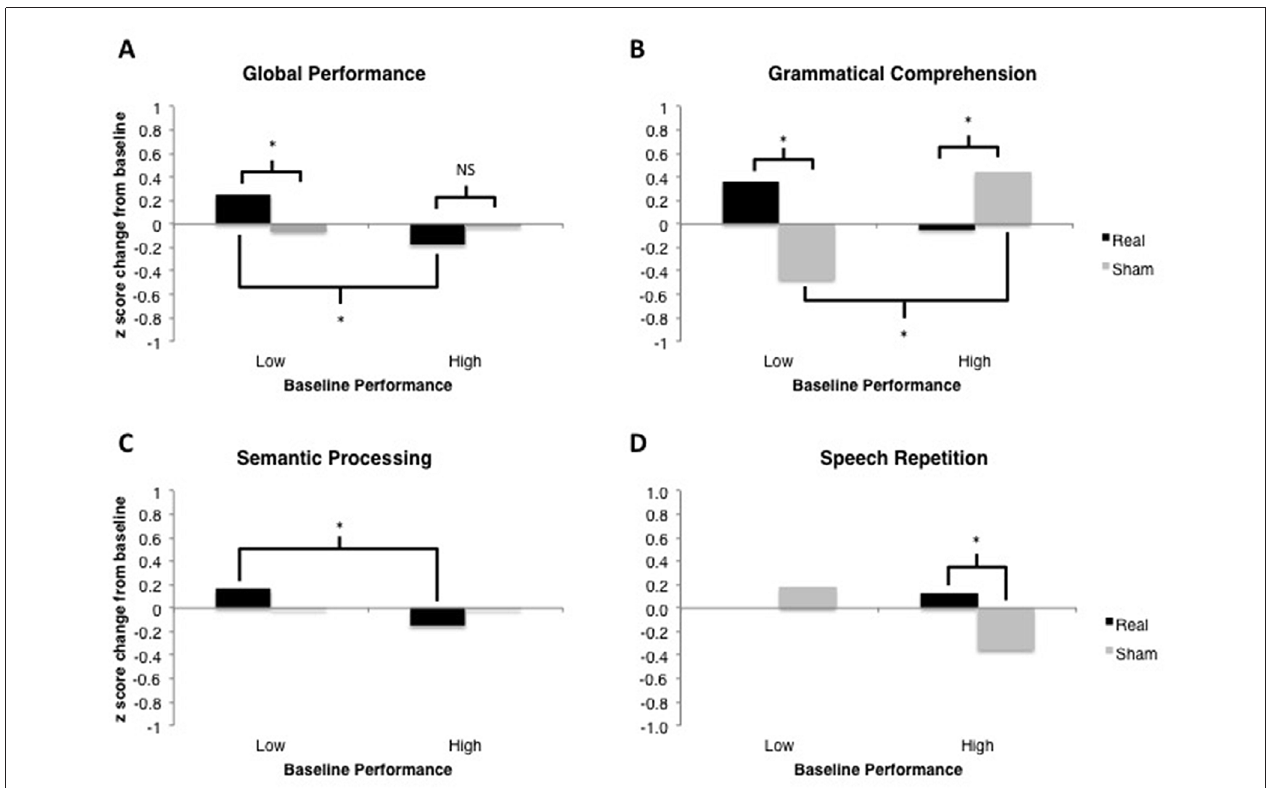
FIGURE 5 | Results of linear mixed-effects tDCS × Baseline Performance analyses for each language domain of interest. Model-estimated means are plotted in units of z-scores measured as change relative to the most recent baseline (i.e., standardized different scores). Asterisks represent significant comparisons at